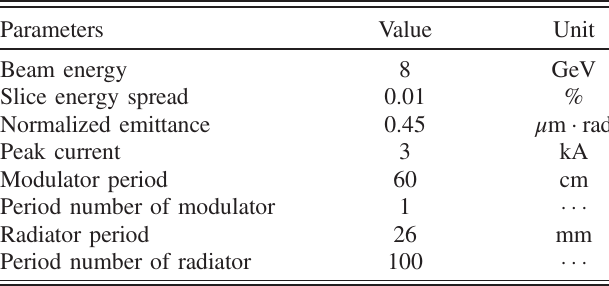
TABLE I. Main parameters of SHINE.